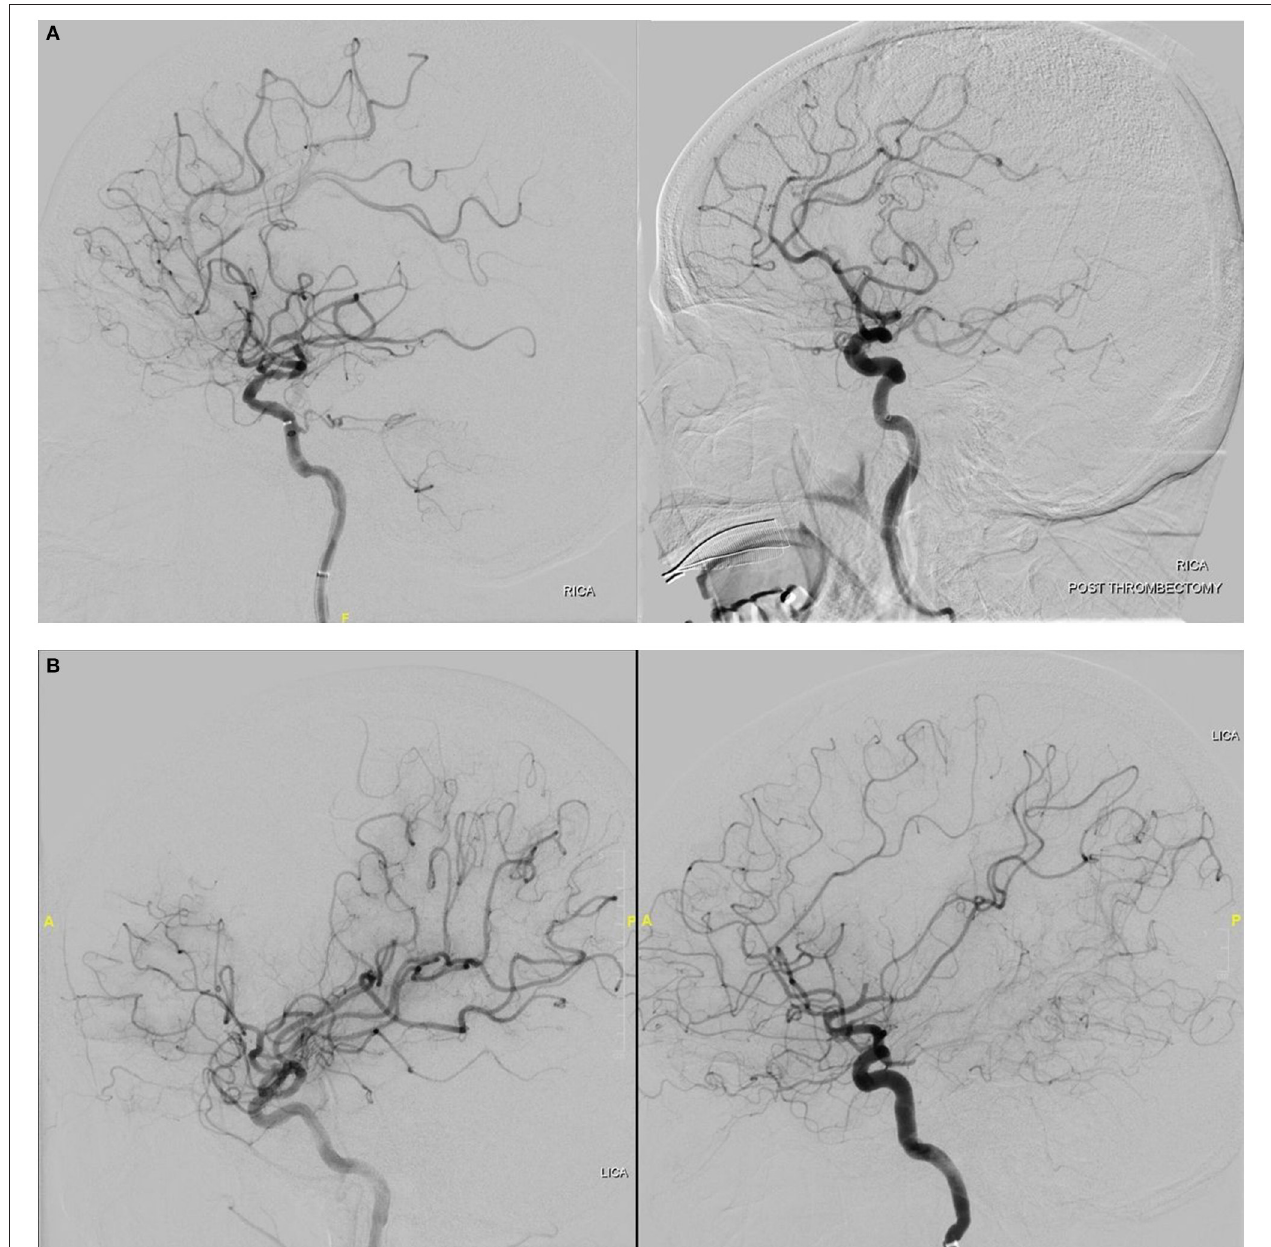
FIGURE 1 | (A) Cerebral digital subtraction angiography showing eTICI 2b50 recanalization in a patient with right MCA occlusion. (B) Cerebral digital subtraction angiography showing eTICI 2b67 recanalization in a patient with left MCA occlusion.